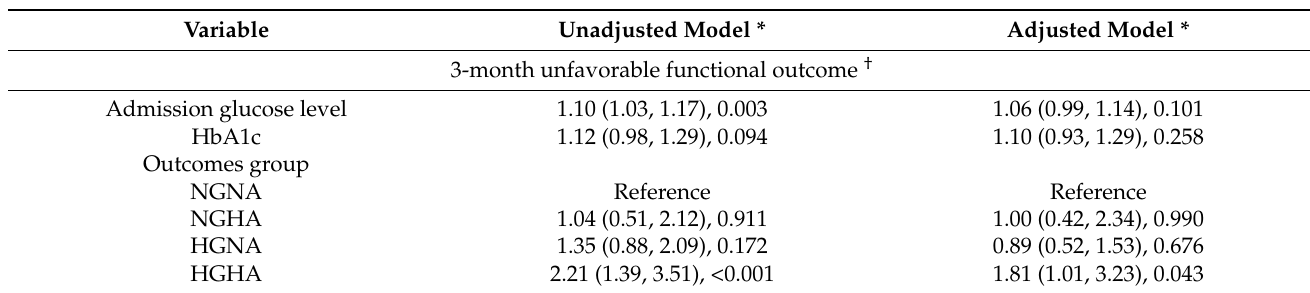
Table 3. Multivariable logistic regression analysis between different groups (divided by admission glucose and HbA1c) and